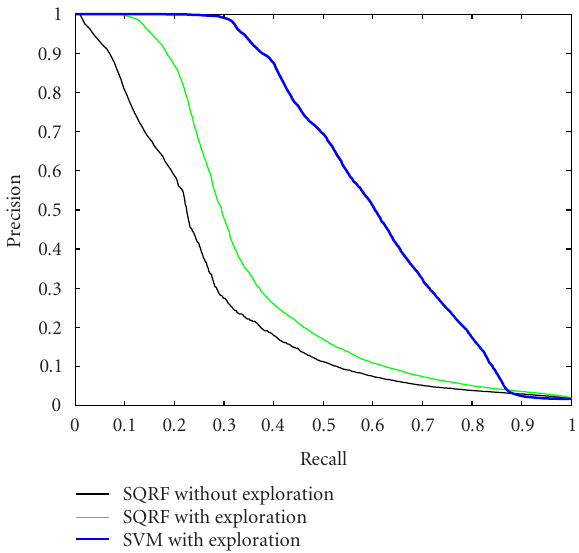
Figure 12: Exploration evaluation: recall according to the number of feedback iterations.